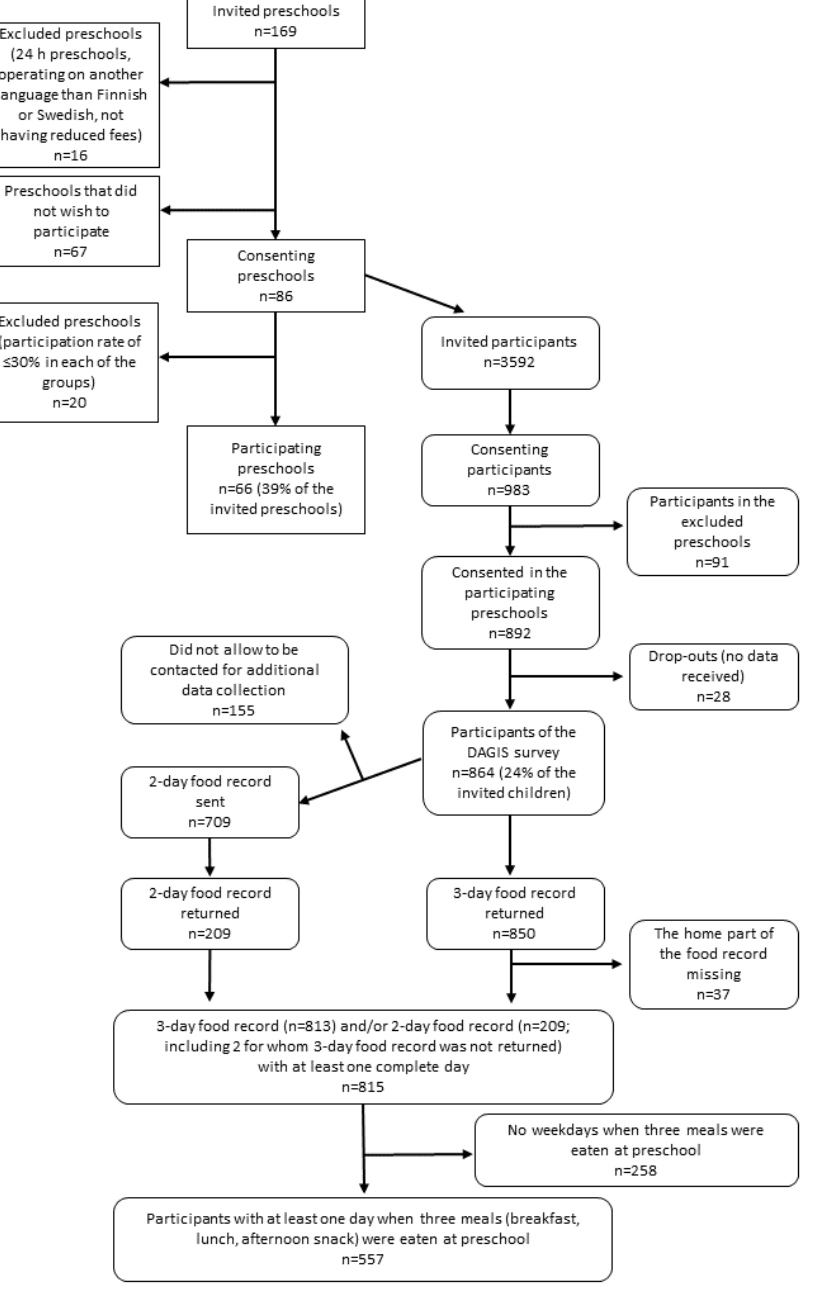
Figure 1. Participation of preschools and children in the DAGIS survey and the selection of participants for this